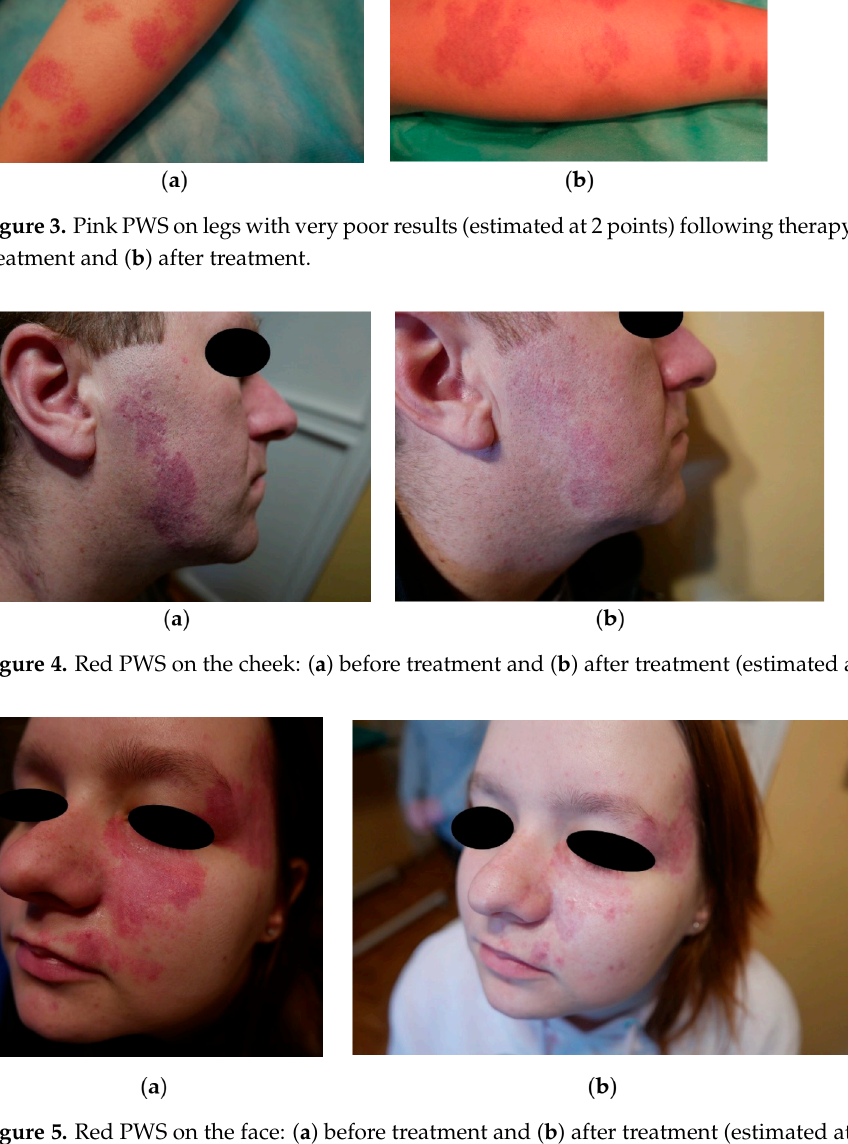
Figure 5. Red PWS on the face: ( a ) before treatment and ( b ) after treatment (estimated at 5 points).